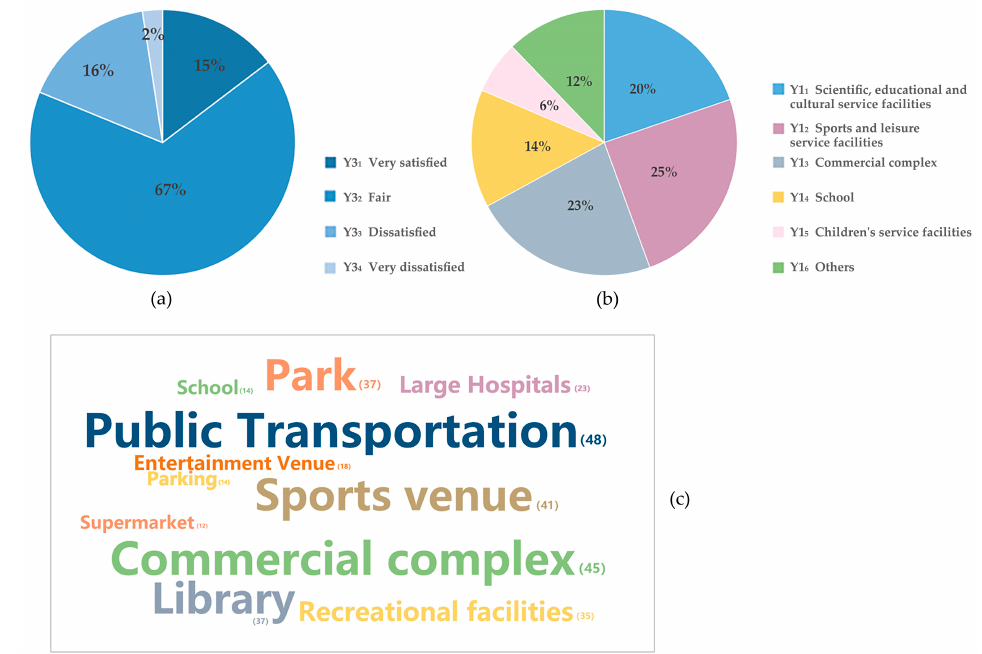
Figure 10. Respondents’ perceptions of the local public service facilities. Note: ( a ) question Y3, satisfaction; ( b ) question Y1, demand for public service facilities; ( c ) word frequency analysis for question Y2.